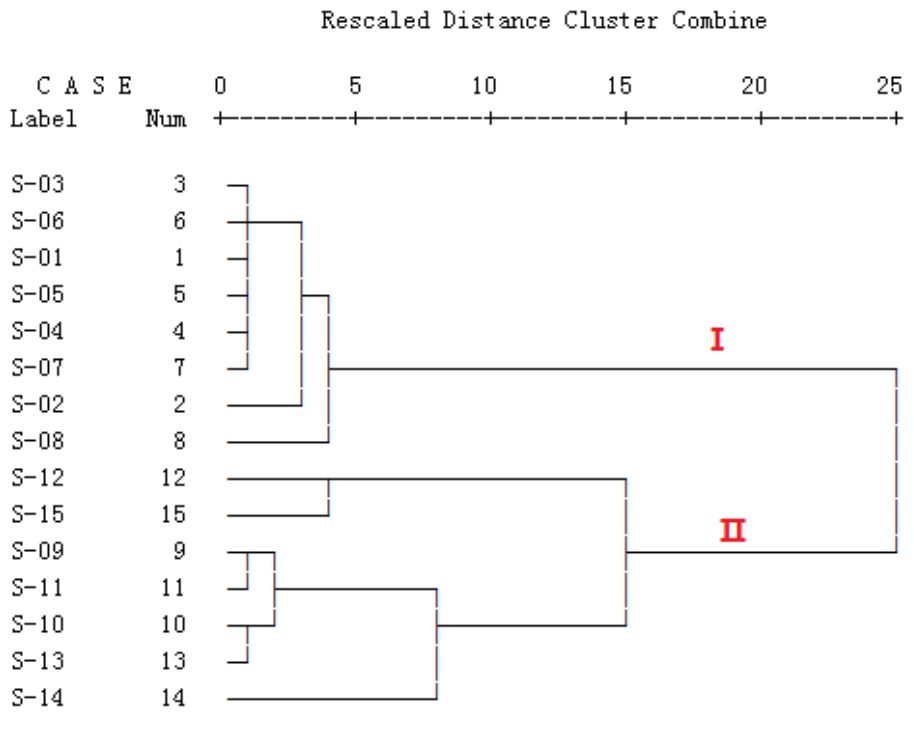
Figure 4. Dendrogram of hierarchical clustering analysis (HCA) for the 15 tested